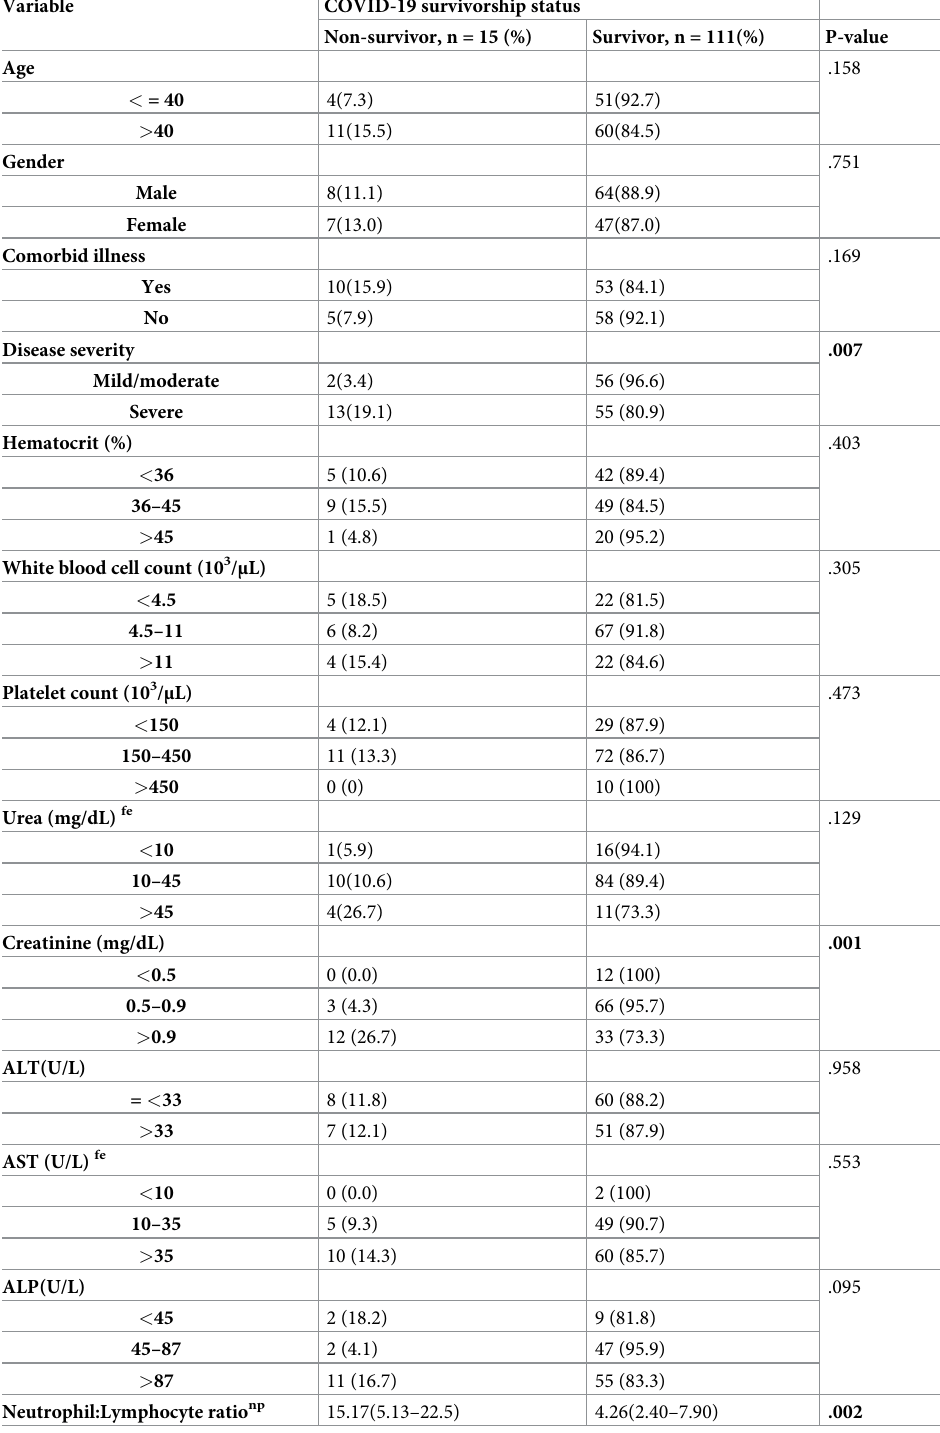
Table 3. Demographic, clinical and laboratory profiles by survivorships